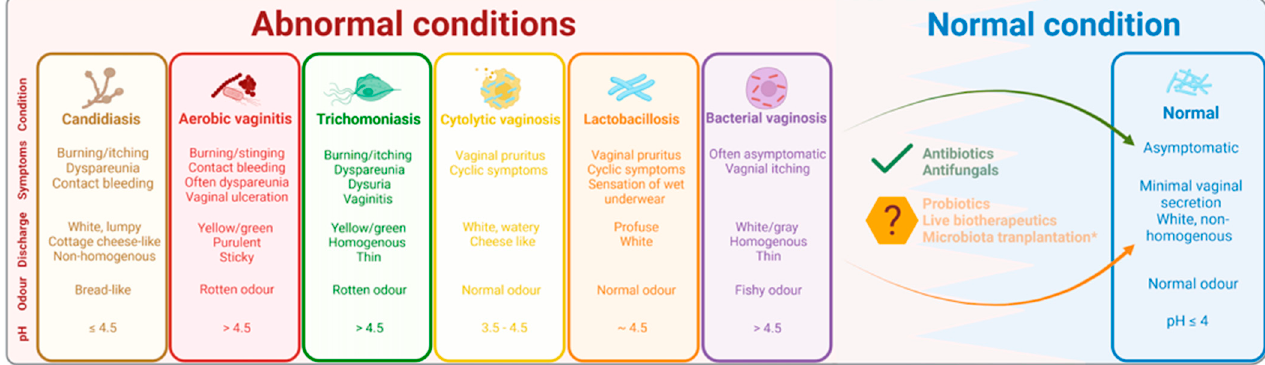
Figure 2. The normal and most common abnormal microbial conditions of the vagina. Created with BioRender.com. Schematic figure showing the characteristics of the most common abnormal microbial conditions of the vagina. Proper diagnosis and treatment can lead to a normal condition. However, recurrent infection and treatment resistance/failure is more and more common, paving the way for new treatment modalities such as probiotics, live biotherapeutics and microbiota